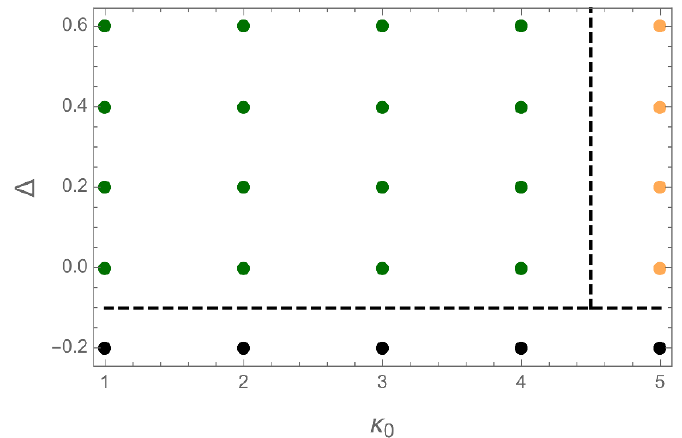
Figure 7 . Preliminary phase diagram of the CDT with toroidal spatial topology ( (cid:6) = T 3 ) for (cid:22) N = 80000 and t tot = 40. Three distinct phases of geometry can be identi(cid:12)ed. Phase A is (4 ; 1) observed for large values of (cid:20) 0 (orange points), phase B for small values of (cid:1) (black points), and phase C for small (cid:20) 0 and large (cid:1) (green points). Approximate position of phase transitions is denoted by dashed lines.